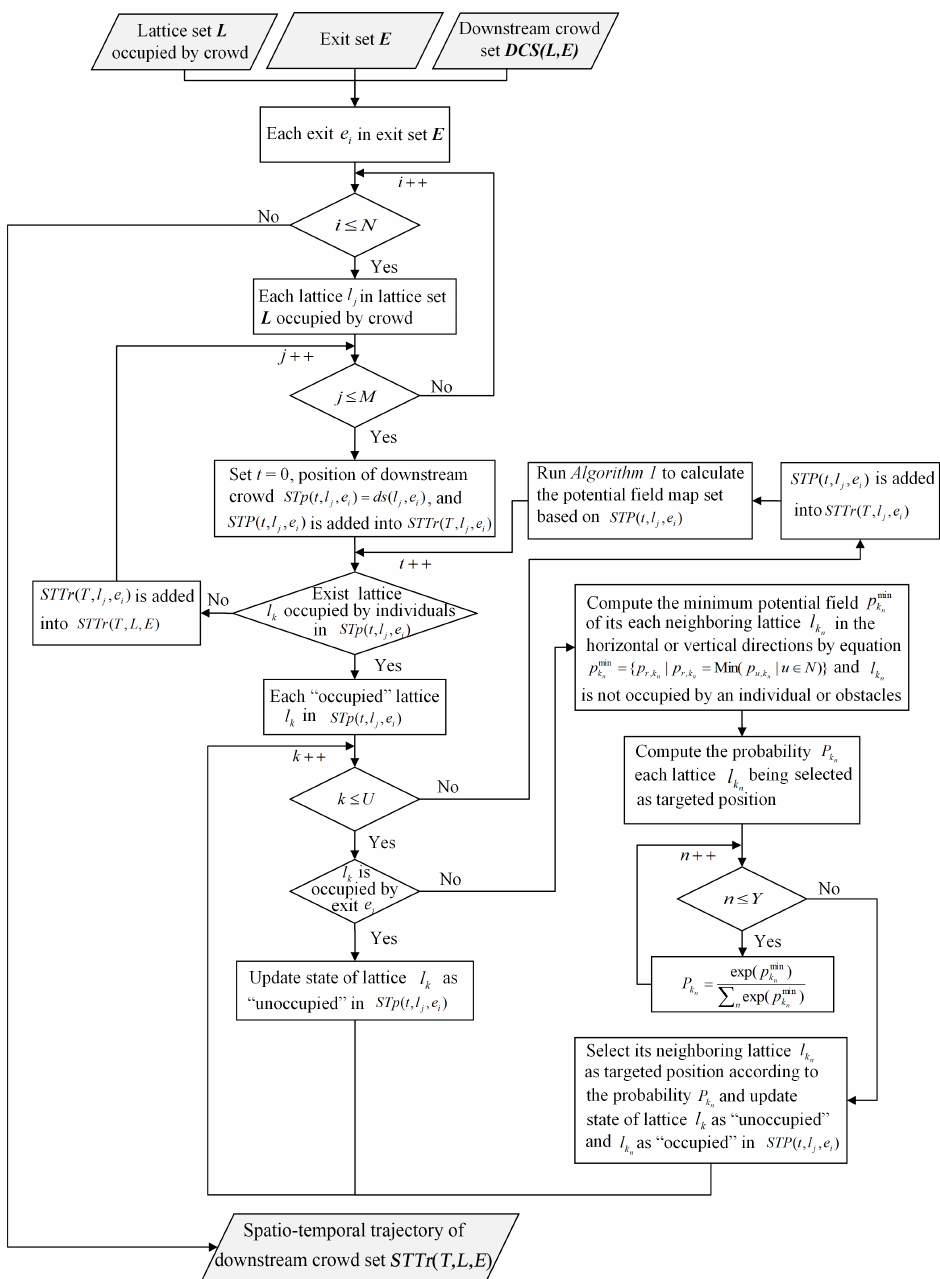
Figure A3. Flowchart of agent-based spatio-temporal trajectory estimation for downstream crowd.